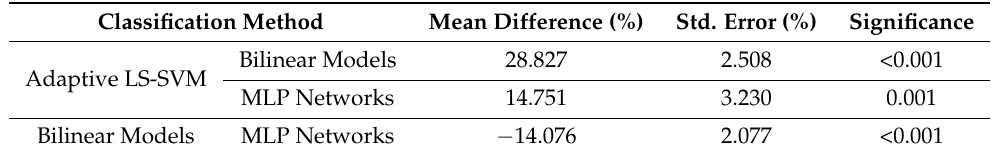
Table 3. Pairwise comparison of the different classification methods using a combination of EMG and IMU data.